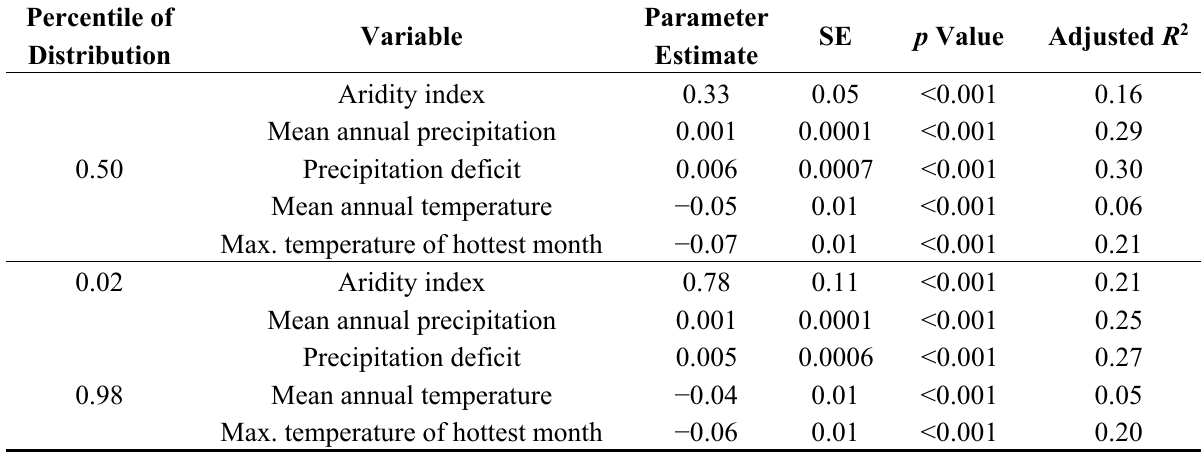
Table 1. Results from regression analysis between osmotic potential at zero turgor versus five different climate indices (aridity index, mean annual precipitation, precipitation deficit, mean annual temperature and mean maximum temperature of hottest month) extracted from observed species occurrences ( n = 174). The 0.50 and 0.98/0.02 percentile values from the species climatic